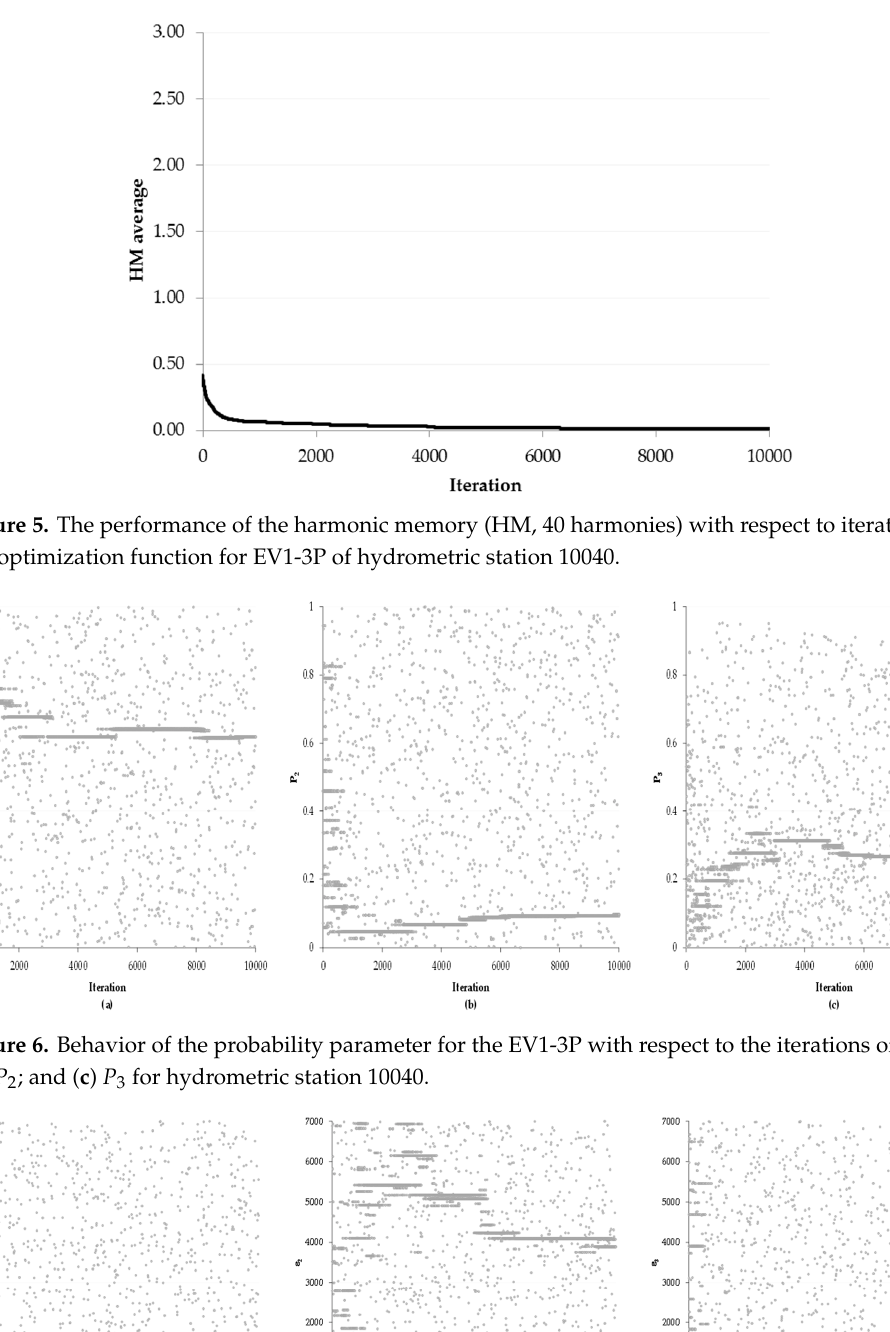
Figure 4. Evolution of the Standard Adjustment Error (EEA) compared to iterations when evaluating the optimization function for the Type I Generalized Extreme-Value Distribution for three populations (EV1-3P) of hydrometric station 10040.